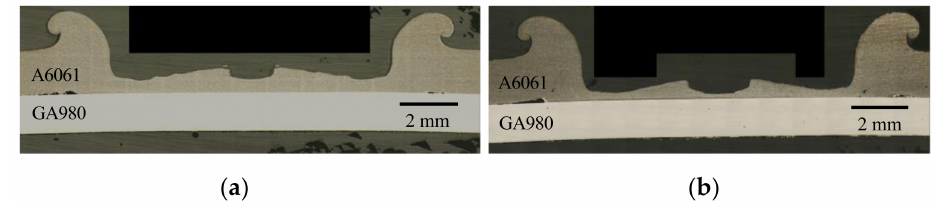
Figure 5. Optical microscope images of cross sections of FSSW joints. ( a ) Welding time: 9 and ( b ) welding time: 10 s.